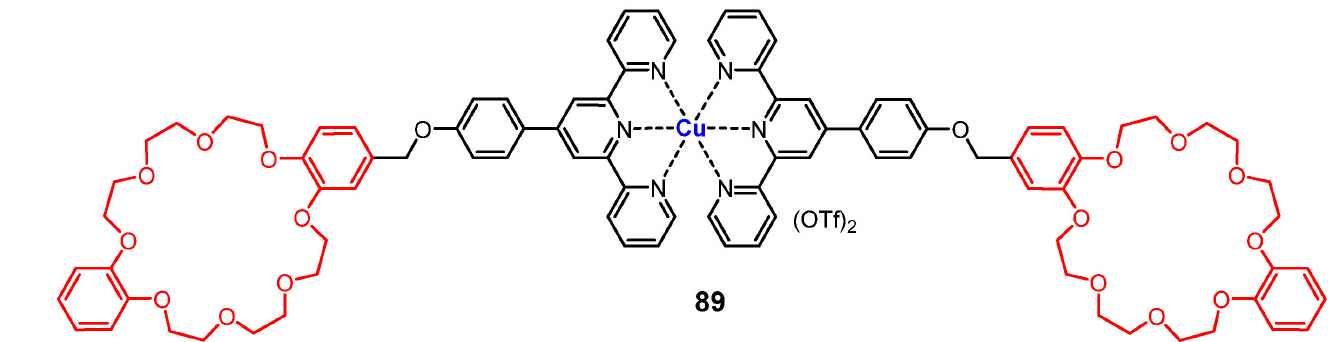
Figure 36. Chemical structures of supra-amphiphile complex 89 . Dendrimers and dendrons are highly branched macromolecules with well-defined molecular structures and have been widely used as building blocks in the self-assembly of supramolecular gel-phase materials [112,113]. Their unique dendritic architecture renders them capable of being modified with metal ions into different positions, such as the den- dritic core, the tether termini, the dendritic branches or the branching points, to develop multiple stimuli-responsive metallogel systems. In 2014, Fan’s group designed and synthe- sized a new class of poly(aryl ether) dendritic ligand with pyridine functionality at the focal point and corresponding Ag(I) complexes 90 – 91 (Figure 37a) [114]. The organometallic dendrimers showed better gelation ability towards various organic solvents with much lower CGCs. The multiple noncovalent interactions, including metal–dendritic ligand coordination, solvophobic interactions and π – π stacking, cooperatively promoted the gela- tion process. These dendritic metallogels were found to be multiple stimuli-responsive supramolecular gels (Figure 37b). They showed a quick response to some anions, such as the chloride ion, bromonium ion, iodine ion and sulfate ion, showing a gel–sol transforma- tion. Excess silver trifluoromethanesulfonate (AgOTf) triggered a sol–gel phase transition. Additionally, these metallogels were also able to respond to neutral chemicals such as pyridine, ammonia and 1,10-phenanthroline, but the response process was not reversible. The thixotropic property was investigated in detail using rheological techniques, and the thixotropic process could be repeated many times. These dendritic metallogels were further used as templates for the in situ formation and stabilization of silver nanoparticles without the use of any chemical reducing/stabilizing agents. Prasad et al. reported another multi- stimuli-responsive organometallic gel based on ferrocene-linked poly(aryl ether) dendrons 92–93 (Figure 37a) [115]. The dendritic metallogelator 93 formed robust stable metallogels in both polar and non-polar solvent/solvent mixtures. This dendritic metallogel was ther- mally reversible, and redox- and chemical-responsive. The gel was changed into a sol and finally became a dark-green solution after stimulation with anodic potential or an oxidant such as [Ce(NH 4 ) 2 (NO 3 ) 6 ]. The resulting solution was transformed into a stable gel after a short period of sonication irradiation. The reversible gel–sol phase transition was attributed to increased repulsion between neighboring ferrocenyl ions during the oxidation process, resulting in a breakdown in intermolecular H-bonding and π – π stacking interactions. These dendritic metallogels also showed a specific response to Pb (II) ions triggering the gel–sol transition, suggesting that they could be an easy detection kit for lead ions, with a detection limit close to the ppb